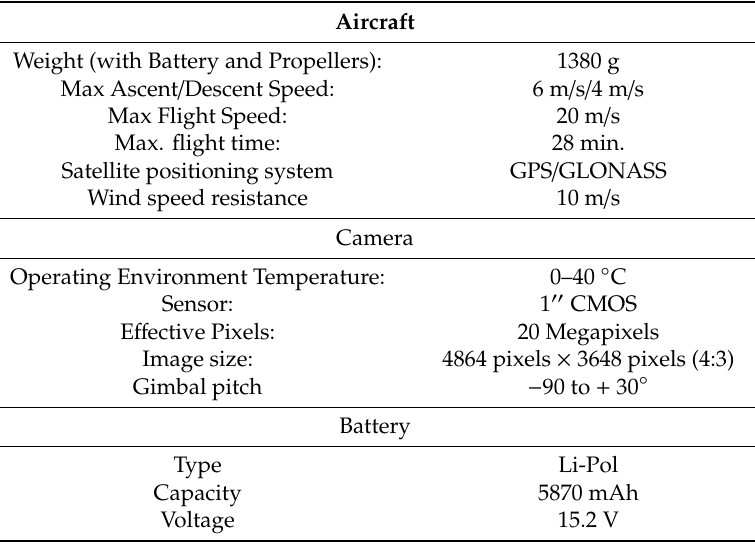
Table 3. UAS DJI Phantom 4 Pro